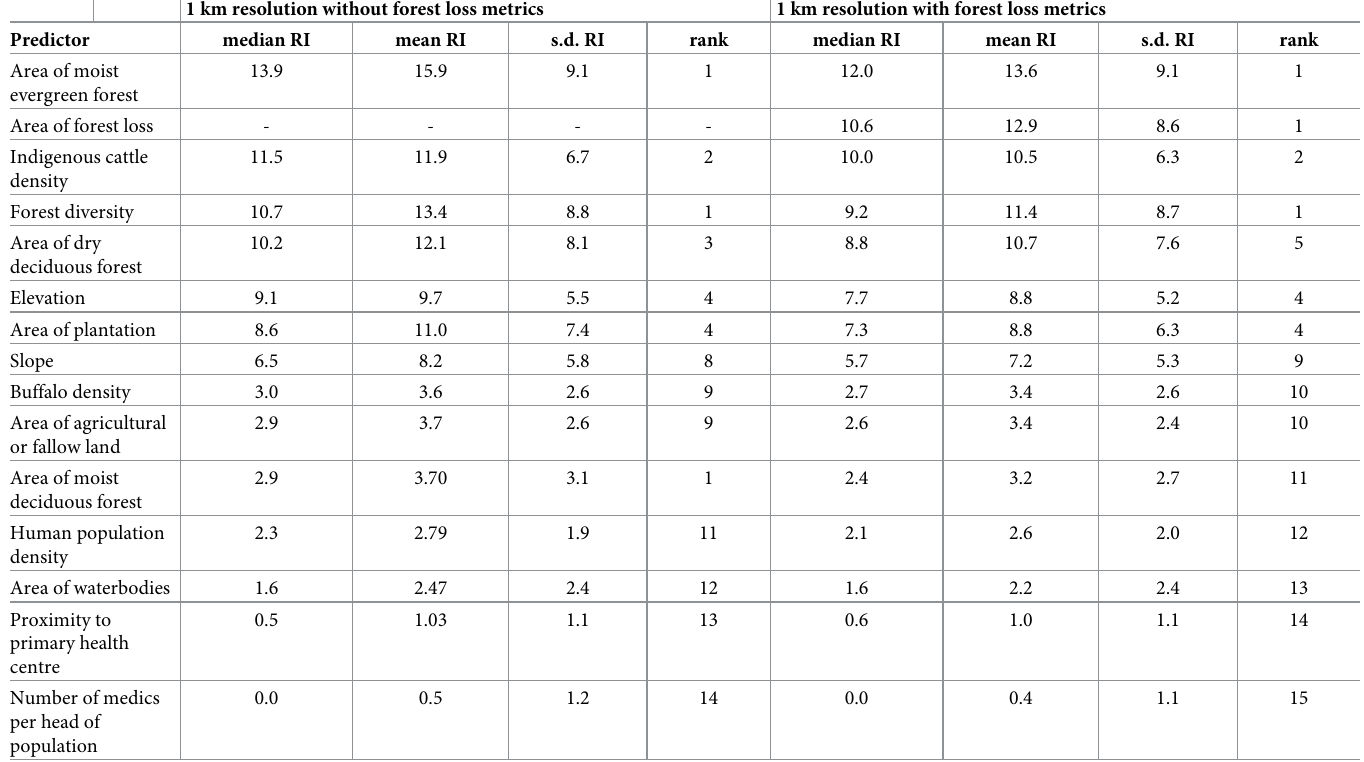
Table 5. Relative importance (RI) and modal rank (rank) of predictors in BRT models at a 1 km resolution (median, mean and s.d. of values across 100 model runs). 1 km resolution without forest loss